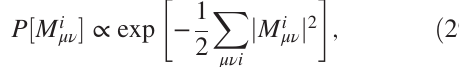
, C X Z =iS gates (four = 6